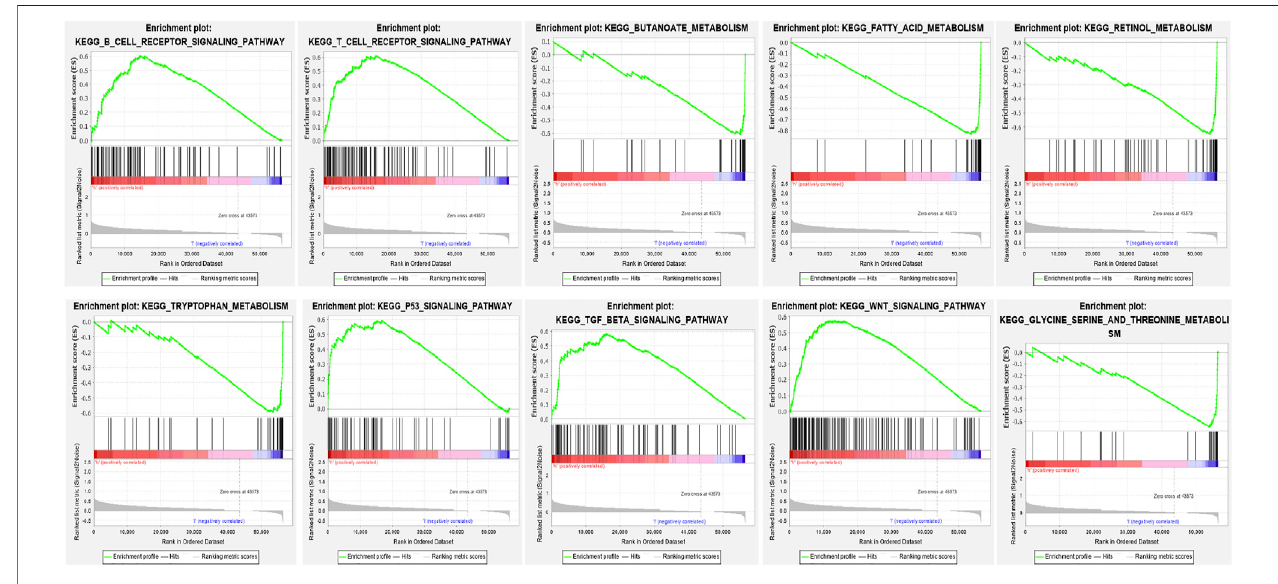
FIGURE 7 | GSEA for two risk groups based on the signature.